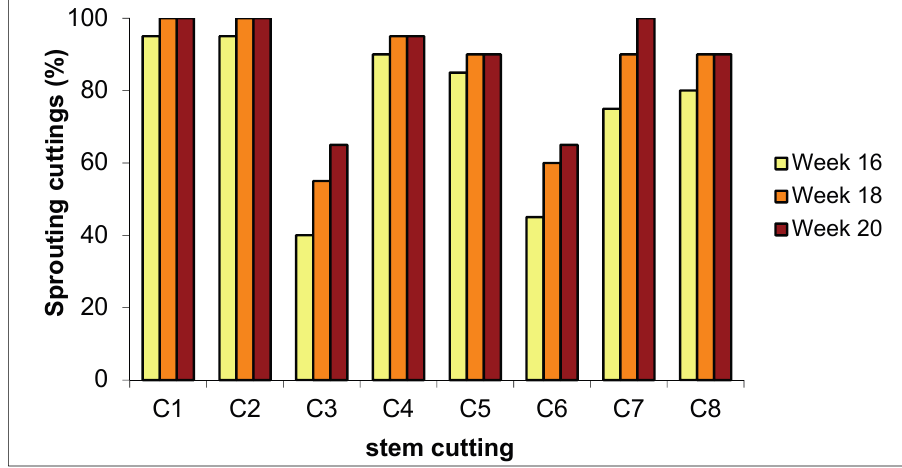
Figure 7. Percentage of sprouted cuttings in a greenhouse trial for Salix cinerea stem cuttings with different concentrations of Cd, Zn and Mn counted 6, 8 and 10 weeks after planting (stem cutting C1 to C8: from lowest to highest Cd concentration in the bark; see Table 5; Scheldt). In total, 20 cuttings were grown per origin.